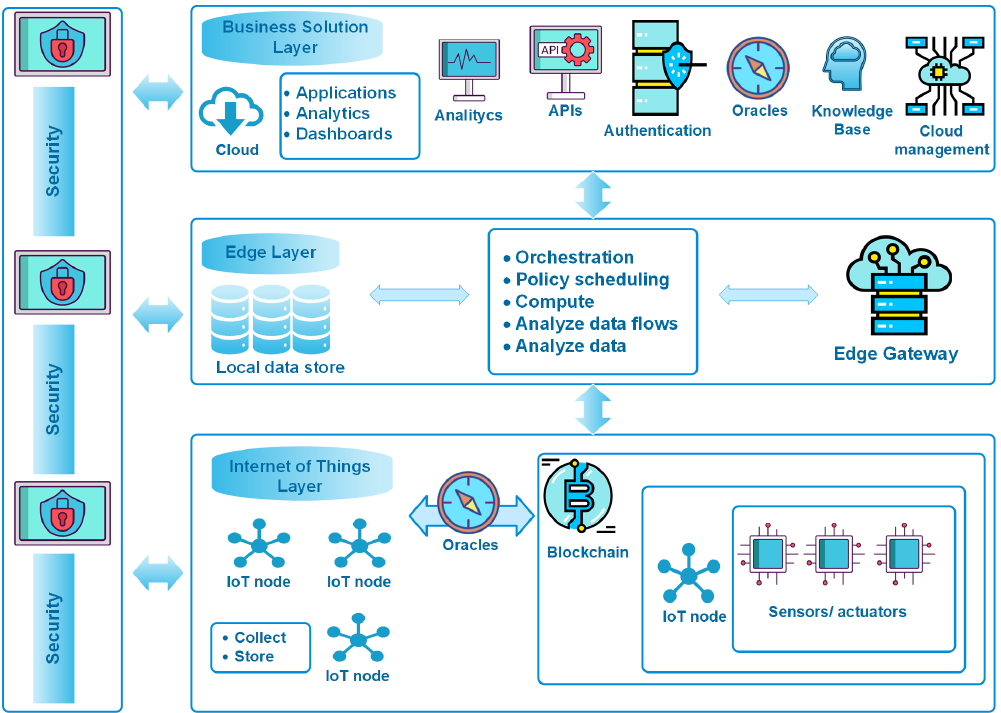
Figure 2. The Global Edge Computing Architecture (based on Sittón-Candanedo et al. [52]).